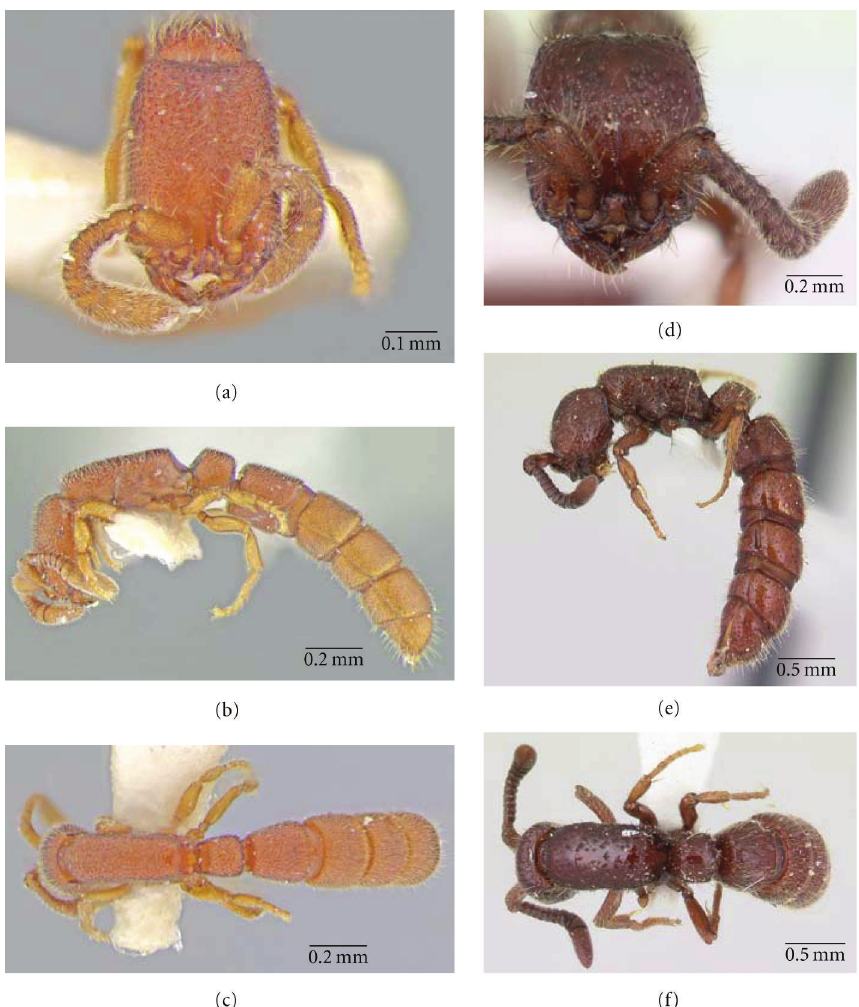
Figure 1: Sphinctomyrmex marcoyi . (a)–(c): Holotype worker from Manaus, AM, Brazil: (a) head in full face view, (b) lateral view, (c) dorsal view. Image by Ricardo Kawada, specimen CPDC 6(4832). Sphinctomyrmex schoerederi . (d)–(e): Holotype worker from Vic¸osa, MG, Brazil: (d) head in full face view, (e) lateral view, (f) dorsal view. Image by April Nobile, specimen CASENT